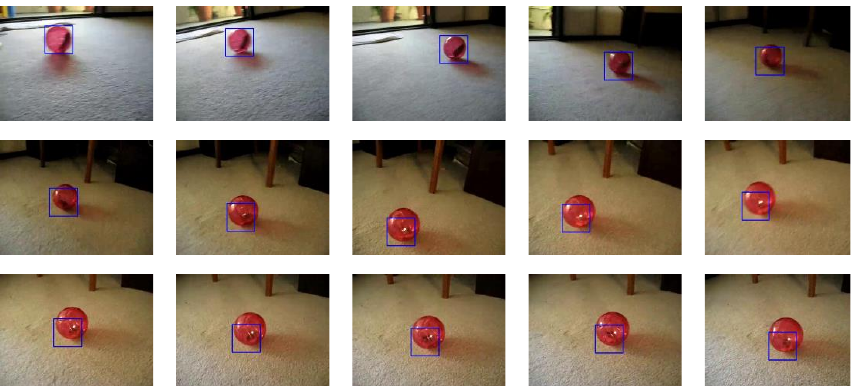
Figure 9. This figure displays some of the video frames that show how the tracker follows the object of interest (hamster ball). This test was made using the proposed embedded system to determine the feasibility of using it to accelerate an exhaustive